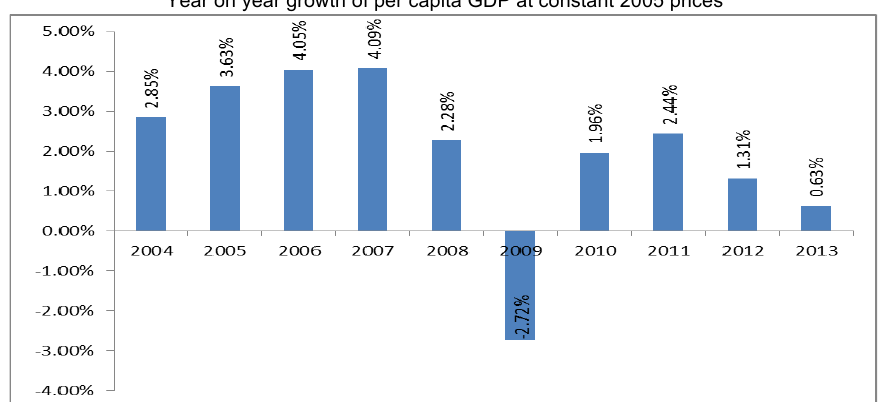
Figure 5 Year on year growth of per capita GDP at constant 2005 prices